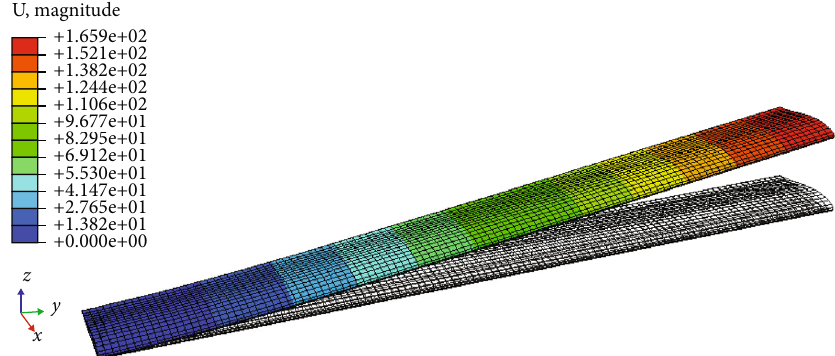
Figure 18: Cloud chart of stress distribution.